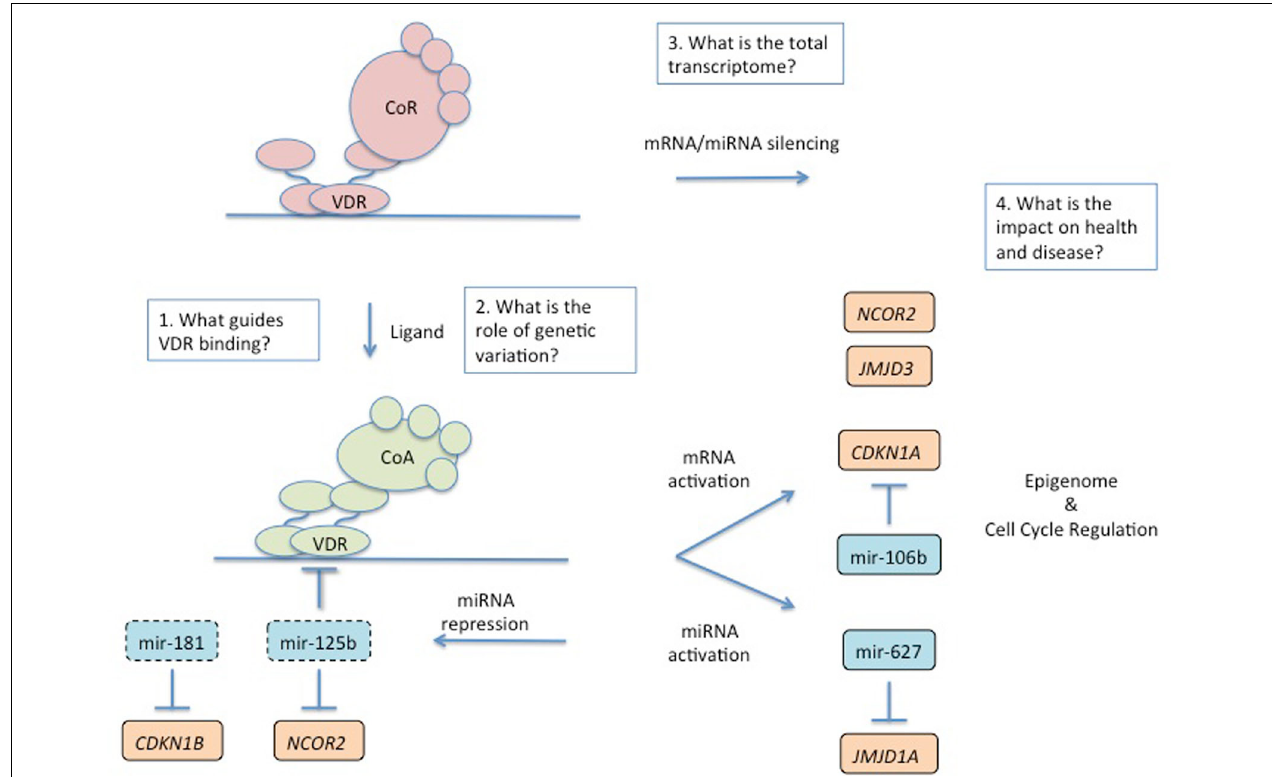
FIGURE 1 | An overview of regulation and impact of the transcriptome by the nuclear VDR and the future challenges. The VDR toggles between a gene repressive and activating complex depending on the presence of ligand. Ligand activated gene regulated scenarios are most well understood. In the presense of ligand the VDR complex is associated with both mRNA and miRNA activation and there is clear evidence for co-regulation of these transcriptomes to tightly control final protein coding gene expression and phenotype. Ligand activated VDR also represses a number of miRNA for example including